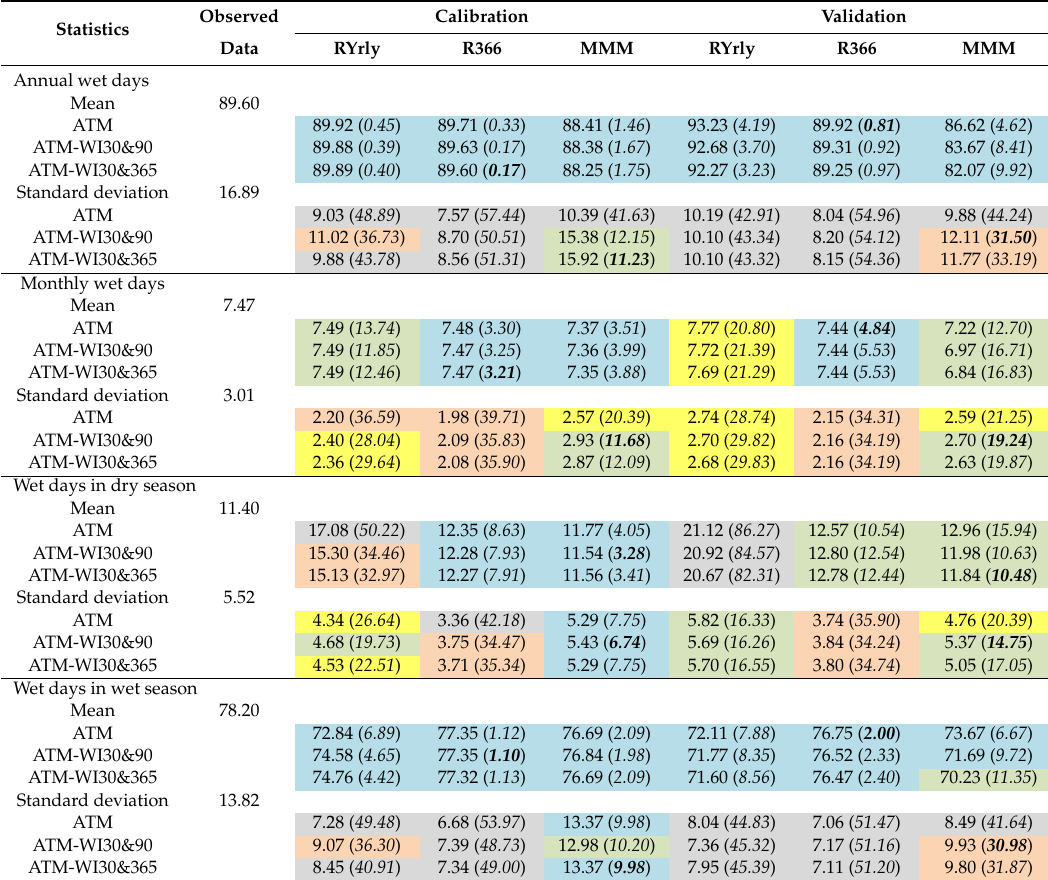
Table 3. Statistics of monthly, seasonal and annual wet days simulated by 3 multisite downscaling techniques for calibration and validation periods. Rel. RMSE is presented in brackets.